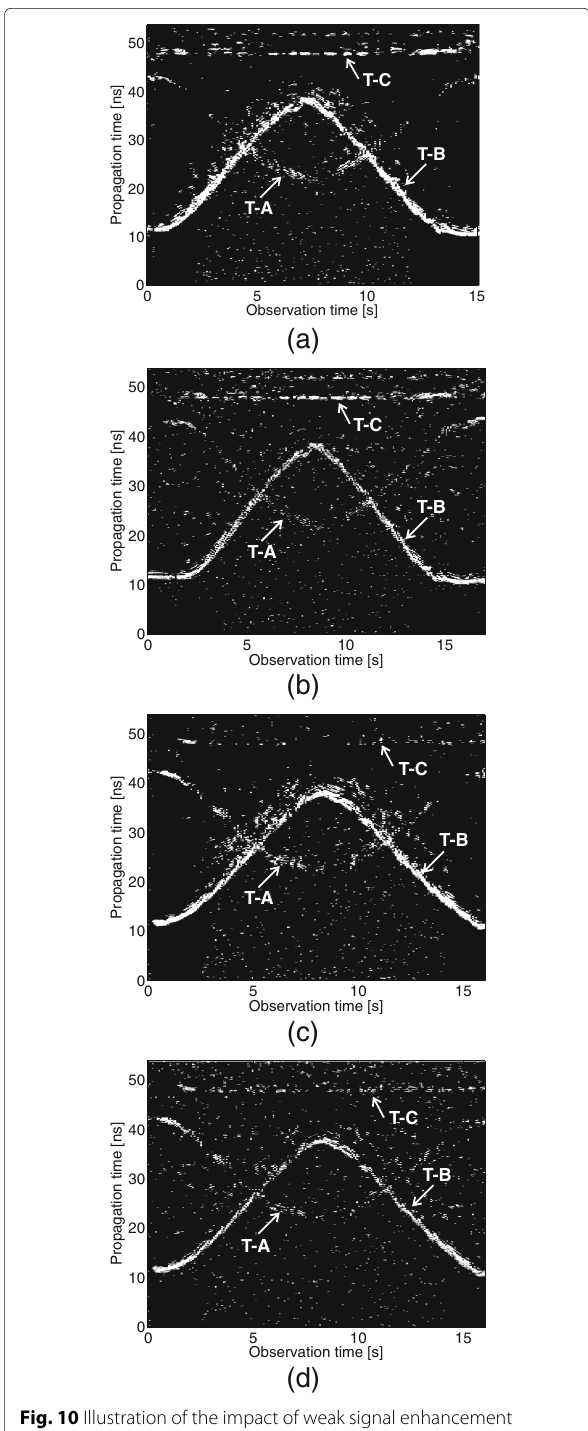
Fig. 10 Illustration of the impact of weak signal enhancement application and radar antenna location on target detection. Scenario 2, sensor S2. The detector outputs for the receiving channel Rx 2,1 : a antenna altitude 1.35 m, no weak signal enhancement has been used; b antenna altitude 1.35 m, advanced normalization has been used; c antenna altitude 1.85 m, no weak signal enhancement has been used; d antenna altitude 1.85 m, advanced normalization has been